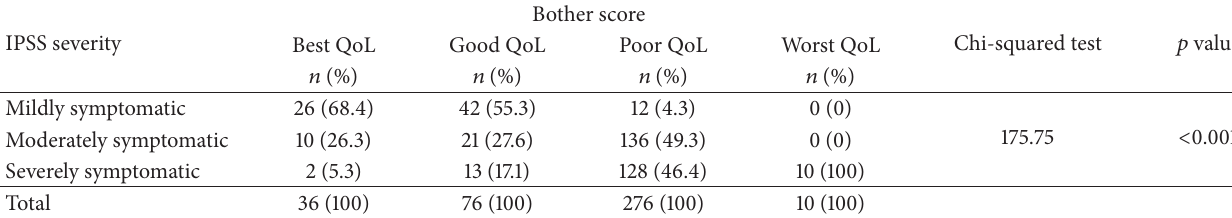
Table 3: Showing the quality of life of the subjects in relation to the severity of LUTS